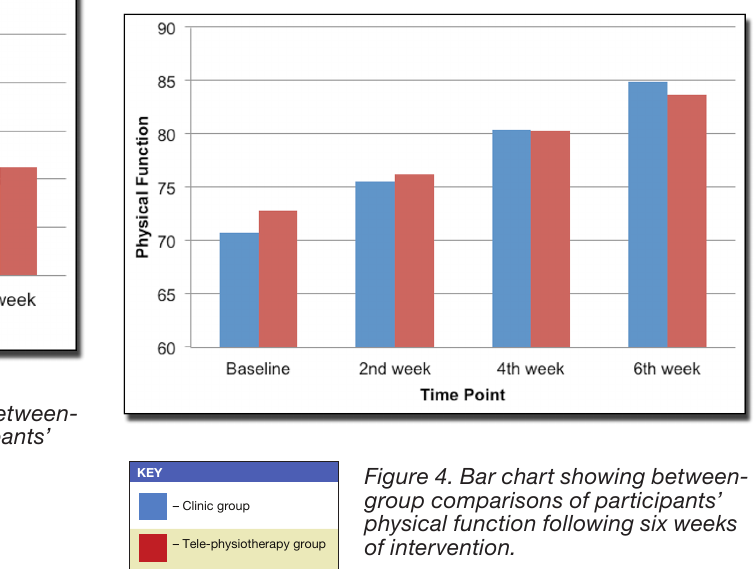
Figure 3. Bar chart showing between- group comparisons of participants’ pain following six weeks of intervention.